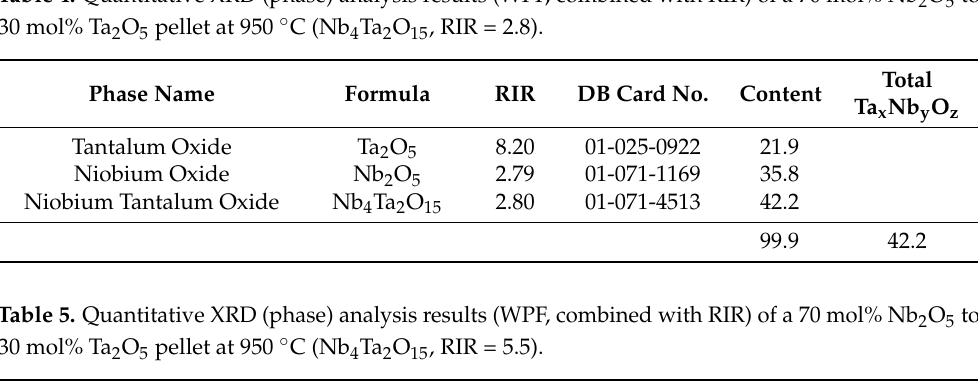
Table 4. Quantitative XRD (phase) analysis results (WPF, combined with RIR) of a 70 mol% Nb 2 O 5 to